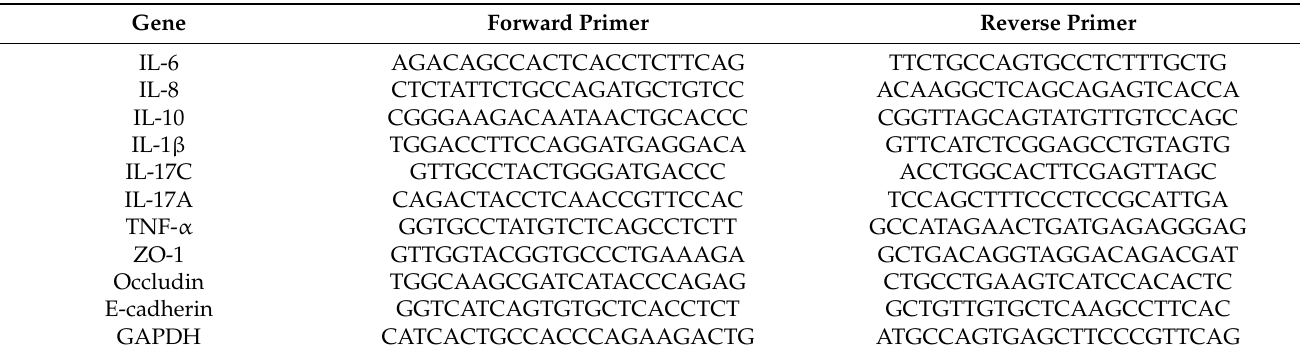
Table 2. Mouse primer sequence for